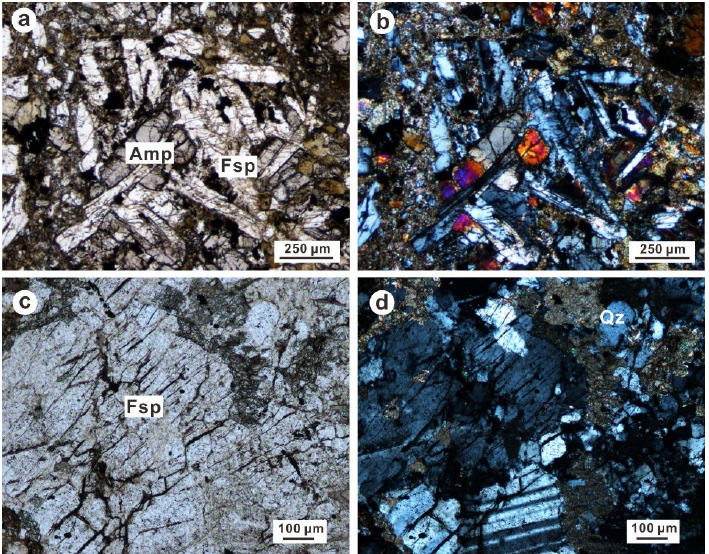
Figure 2. Weakly shocked feldspars. ( a ) Feldspar grains in lithic breccia display irregular fractures (PPL). ( b ) Some feldspar grains show undulatory extinction (cross polarized light, XPL). ( c , d ) Feldspar grains in suevite display many irregular fractures and undulatory extinction (c—PPL, d—XPL). Fsp—Feldspar, Amp—Amphibole, Qz—Quartz.